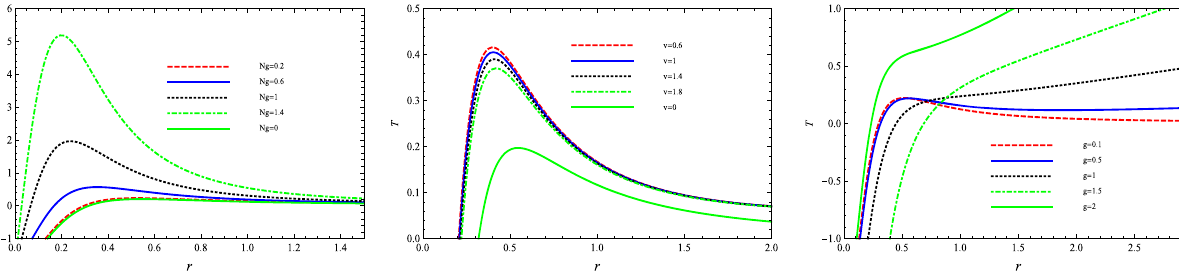
Fig. 4 The variation of temperature with ‘r’ for different values of (i) NUT charge N g , (ii) magnetic charge ν and (iii) gauge coupling constant g at a = 0 . 5 , M =